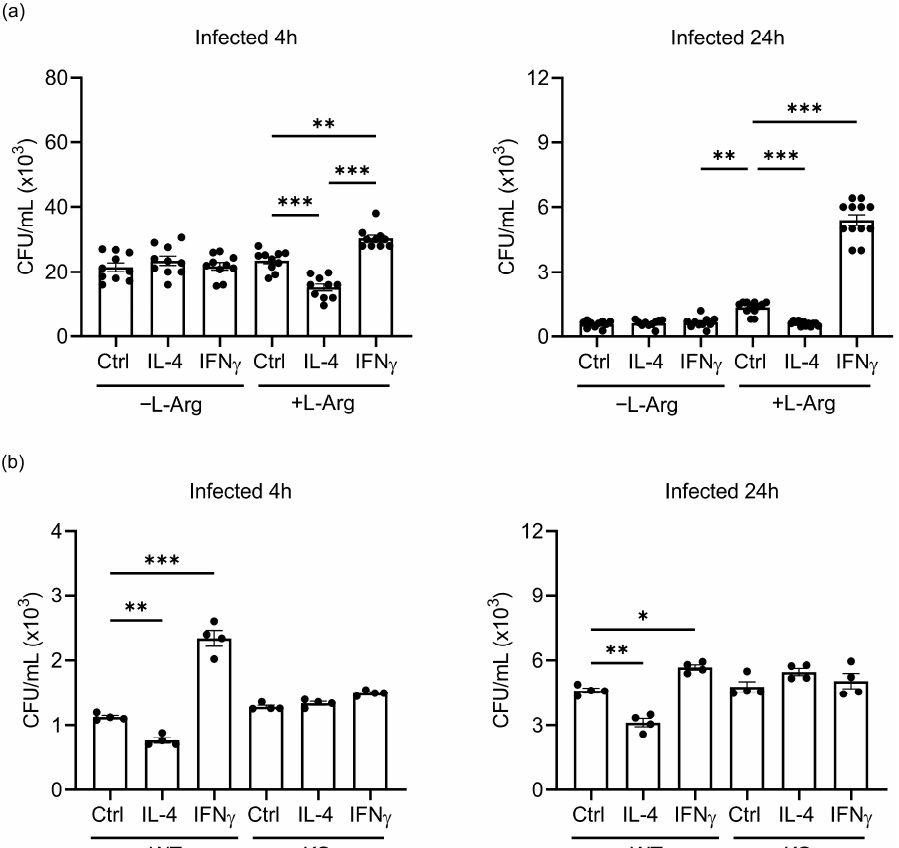
Figure 9. IL-4 exerts its inhibitory effect on S .tm proliferation via L-arginine-mediated metabolic pathways. Effects of L-arginine depletion and deletion of ARG1 on S .tm survival in macrophages was analysed. BMDM generated from C57BL/6N mice were cultured in L-arginine-free